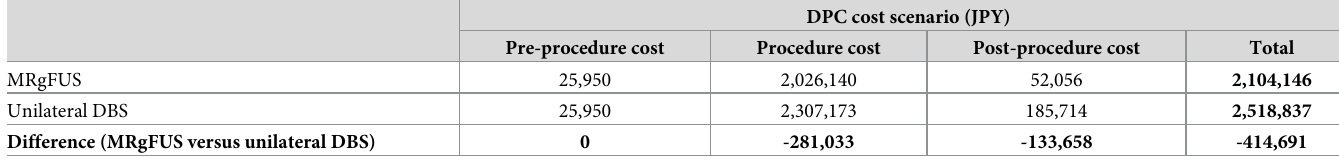
Table 2. Costs per procedure by procedure stage in the DPC cost